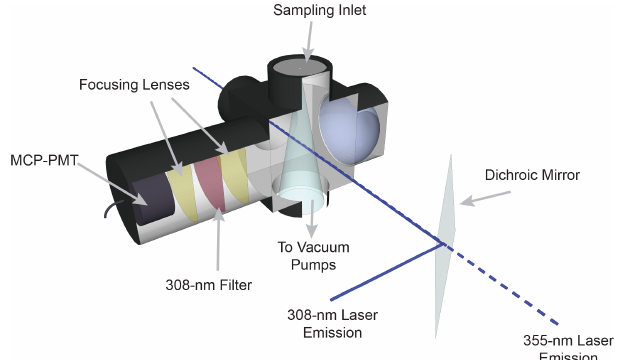
Figure 2. Diagram of the LP/LIF sampling